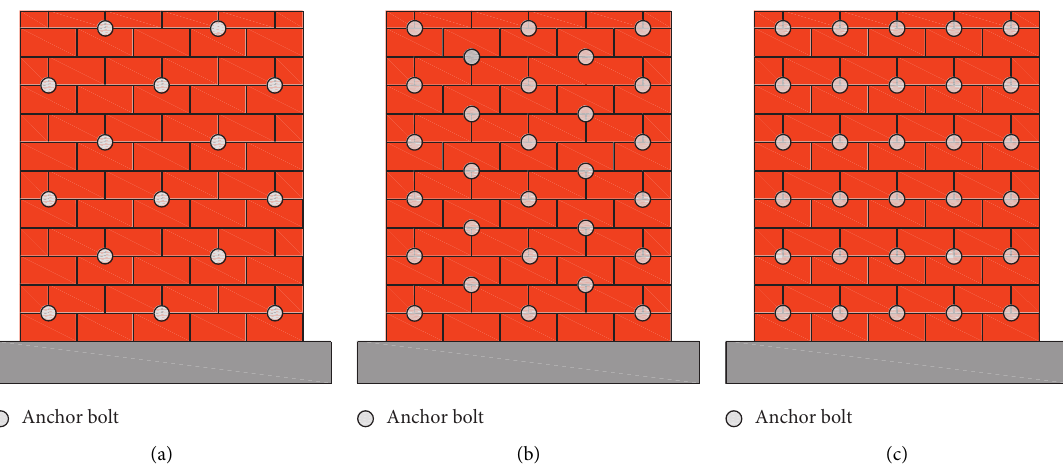
Figure 5: The arrangement of anchor bolts. (a) AB2. (b) AB4-1. (c)